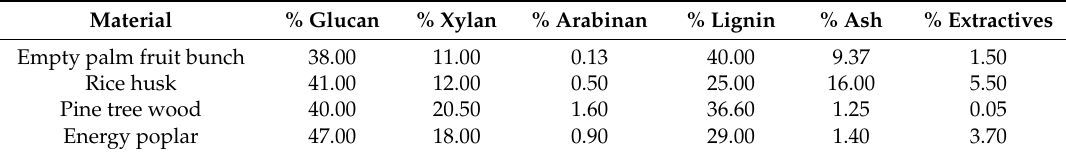
Table 1. Composition of selected lignocellulosic feedstock materials